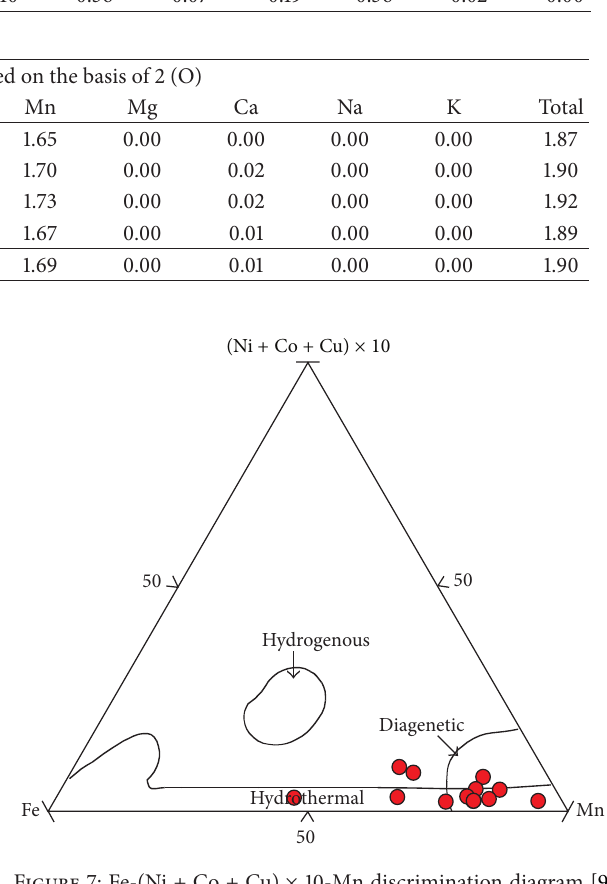
Figure 6: Ni-Zn-Co discrimination diagram [6]. Figure 7: Fe-(Ni + Co + Cu)